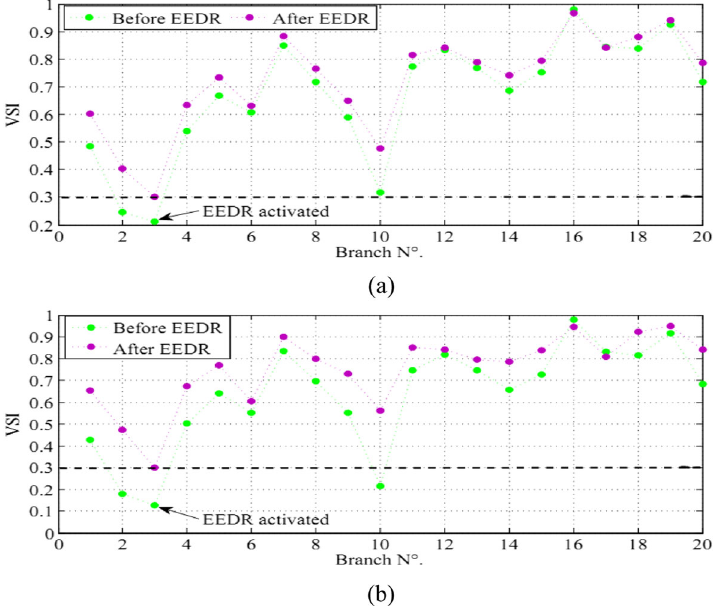
Fig. 16 VSI of the IEEE 14-bus system in the case of (a) increasing of load by 170%, (b) increasing of load by 190%